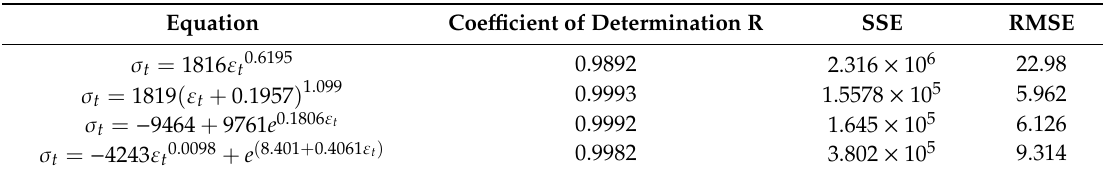
Table 1. Fitting equation of the stress–strain curve of the superalloy GH1140. Equation Coefficient of Determination R